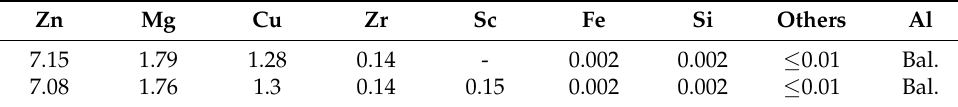
Table 1. Chemical composition of the experimental alloy (wt